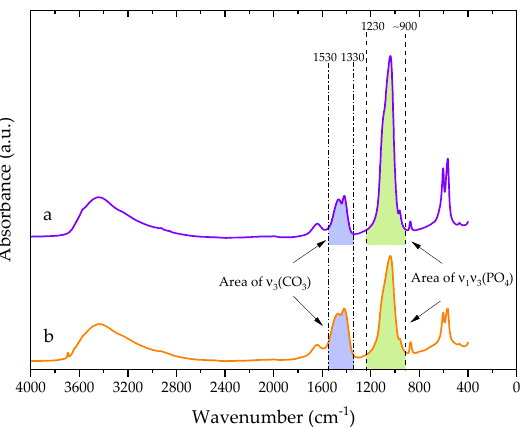
Figure 4. FT − IR absorbance spectra of nHAp powder (a) 1DP − nHAp and (b) 2DP − nHAp. Figure 4. FT-IR absorbance spectra of nHAp powder (a) 1DP-nHAp and (b) 2DP-nHAp.